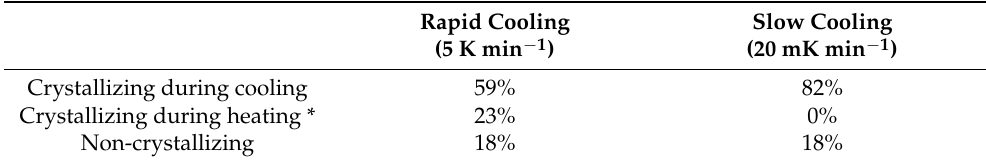
Table 1. Water in the Sephadex ® G25 gel ( h = 1.00) classified in terms of the ice-crystallizing behavior during rewarming